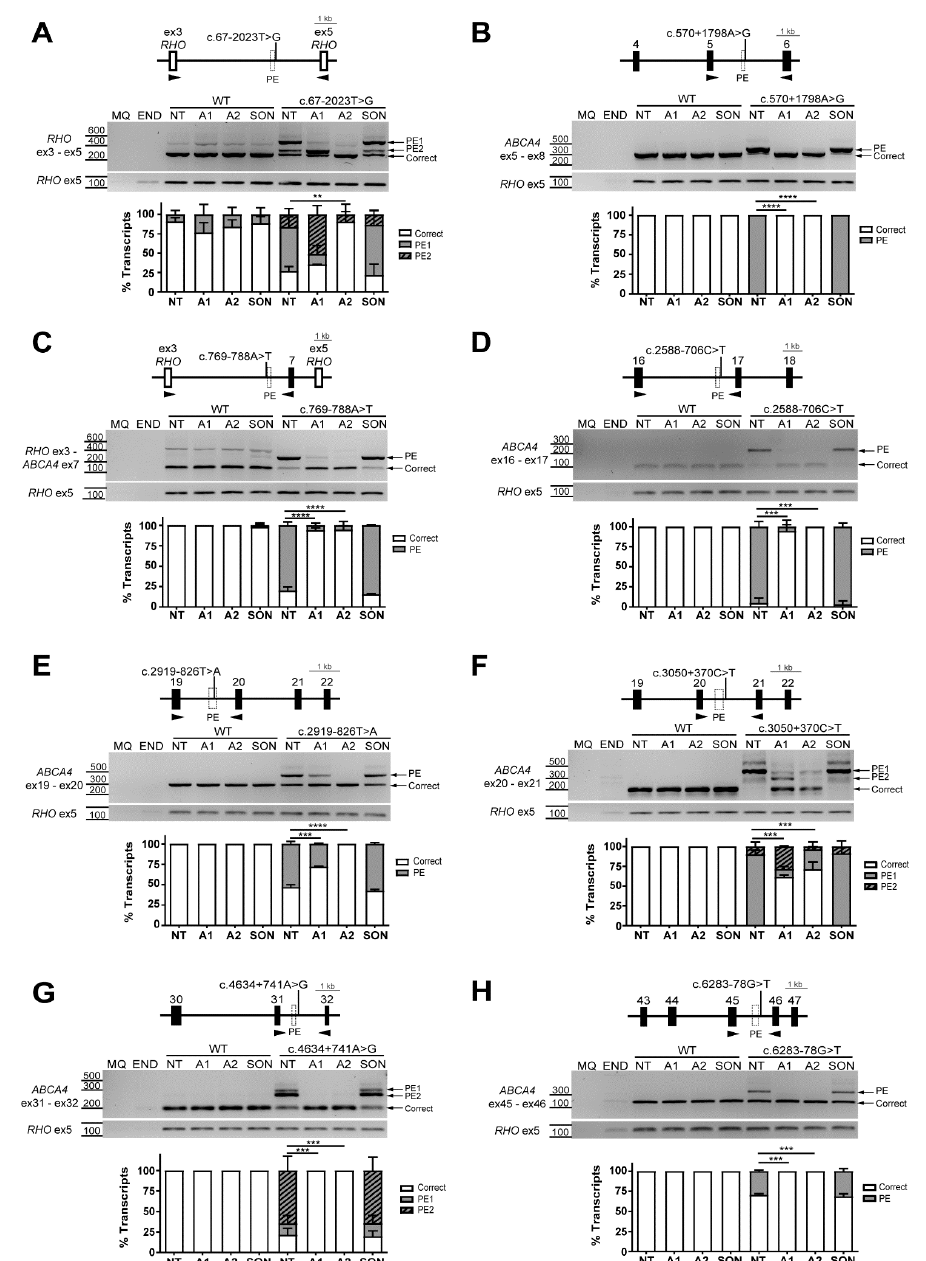
Figure 3. Antisense oligonucleotide (AON)-mediated rescue for deep-intronic splice variants causing non-overlapping pseudoexon (PE) inclusions. Analysis of splicing correction by reverse transcription polymerase chain reaction (RT-PCR) upon AON (A#) delivery. Wild-type (WT) midigenes and the corresponding mutant midigenes containing deep-intronic variants c.67-2023T>G ( A ), c.570+1798A>G ( B ), c.769-788A>T ( C ), c.2588-706C>T ( D ), c.2919-826T>A ( E ), c.3050+370C>T ( F ), c.4634+741A>G ( G ), and c.6283-78G>T ( H ) were transfected in HEK293T. Non-transfected HEK293T were used as endogenous expression control (END). The different AONs and a SON were then delivered, except for the non-treated lanes (NT). Genomic region of the different midigenes is depicted on top of each representative RT-PCR image, whereas the graphs below represent the semi-quantification of the resulting RT-PCR products, showing the percentage of correct and PE-including transcripts. For each deep-intronic variant causing PE inclusion, at least one AON could significantly restore 100% of the correct transcript, except for c.67-2023T>G and c.3050+370C>T. MQ shows the negative control of the PCR reaction and amplification of exon 5 of the rhodopsin ( RHO ) gene was used as a transfection control. Data (n = 2) are presented as mean ± SD. Statistical significance is indicated as ** p < 0.01, *** p < 0.001 and **** p < 0.0001 using one-way